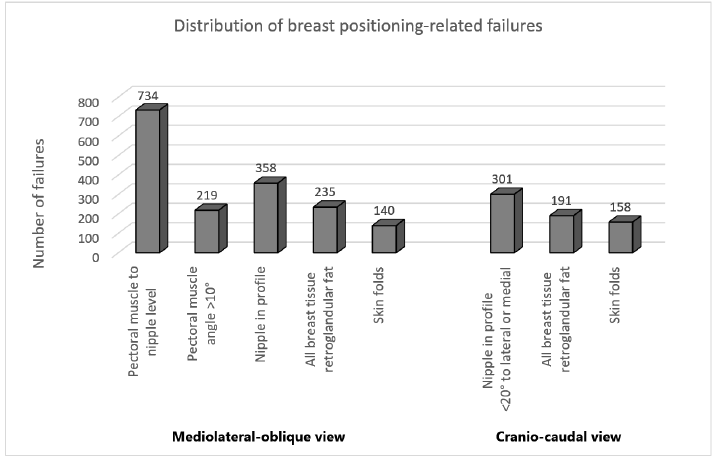
Figure 8. Distribution of the positioning-related failures of the assessed MLO and CC